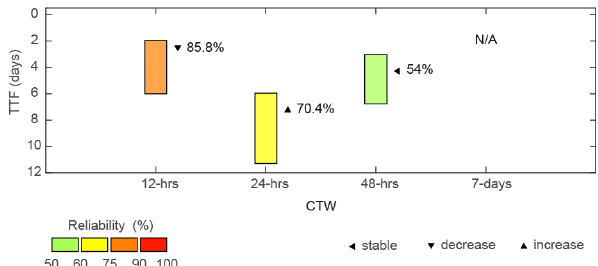
Figure 2. Example of the failure forecast plots. The x axis rep- resents the different computational time windows (CTWs), while the y axis indicates the predicted time to failure (TTF = ToF-now, where now is the time of the current computation). The bar length is a function of the TTF range between 5 and 95 percentiles computed with the bootstrap procedure (see text for details). The bar colors depend on the forecast model reliability values ( R ). Black triangles indicate the reliability tendency with respect to the previous model: an increase (or decrease) occurs when current R is higher (or lower) by 1%. N/A indicates that the modeling results are not reliable; thus the failure forecast model is not